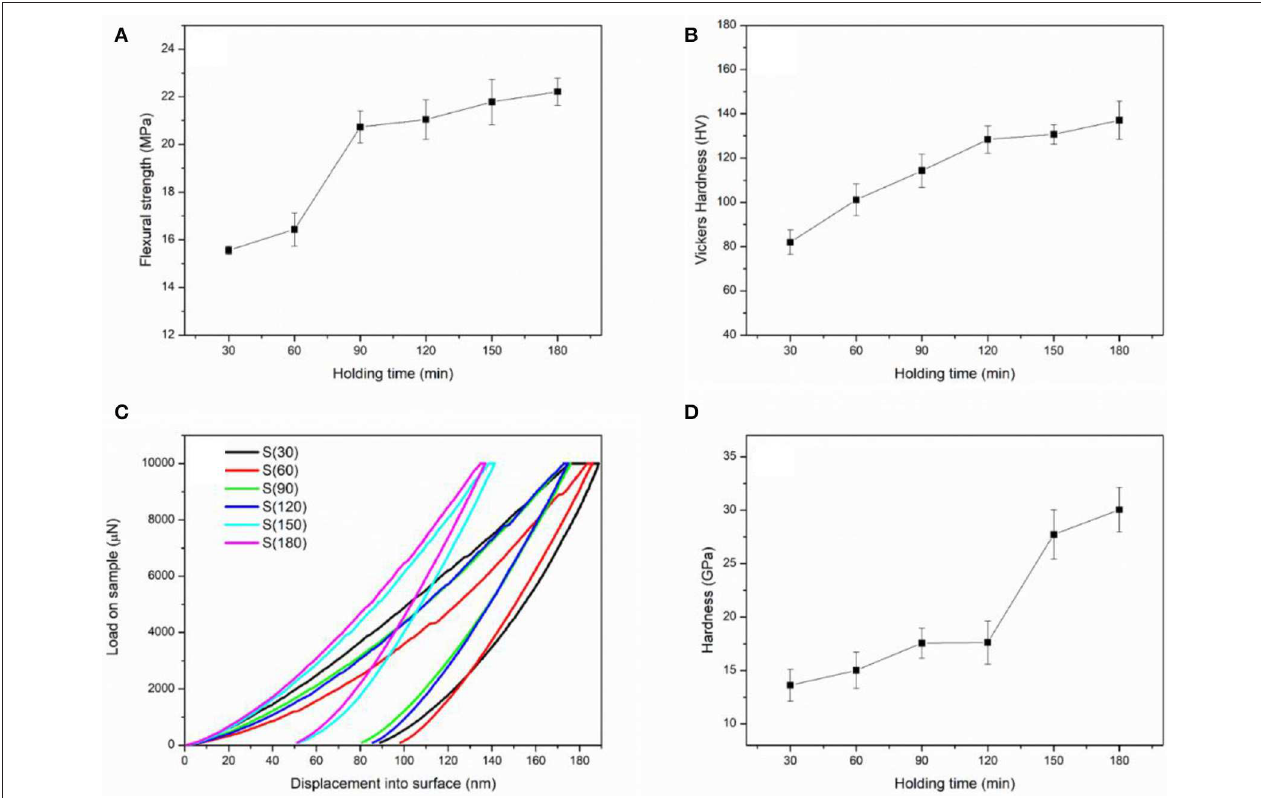
FIGURE 13 | Mechanical properties of the samples sintered with different holding times: (A) Flexural strength; (B) Vickers hardness; (C) Load-displacement curves from nano-indentation tests; (D) Hardness obtained from nano-indentation tests.